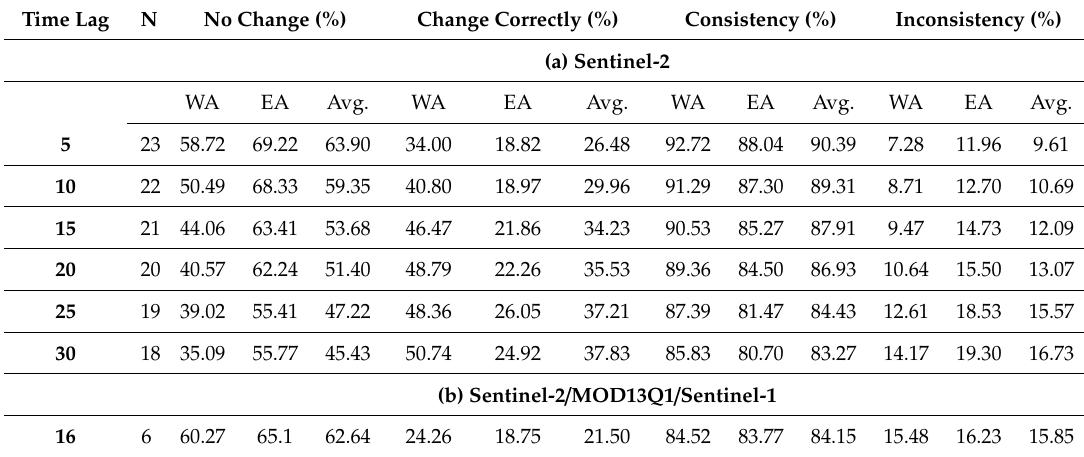
Table 2. List of the average of performance from temporal changes analysis of ( a ) Sentinel-2 and ( b ) Sentinel-2 / MOD13Q1 /